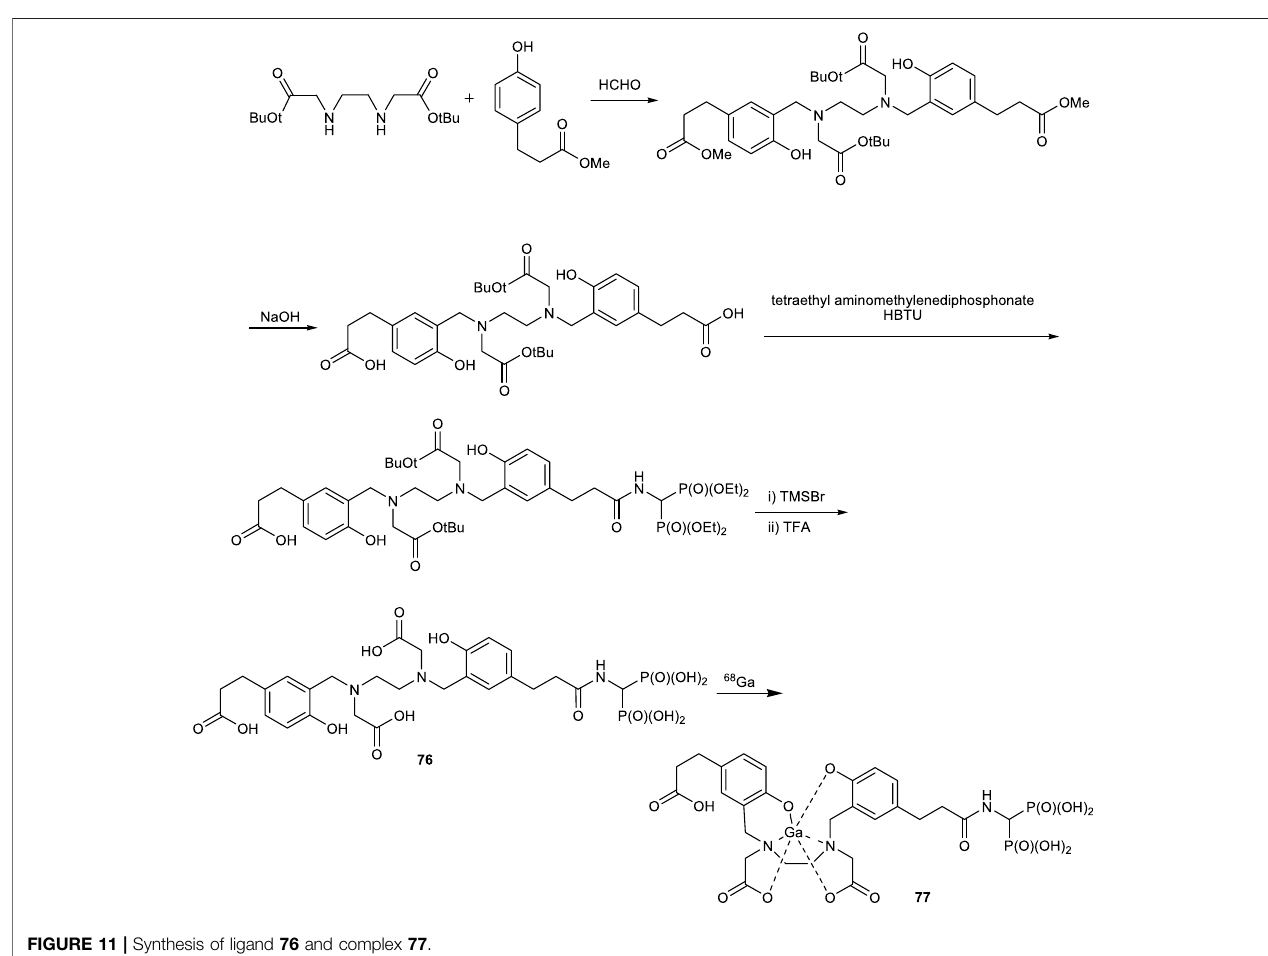
FIGURE 11 | Synthesis of ligand 76 and complex 77